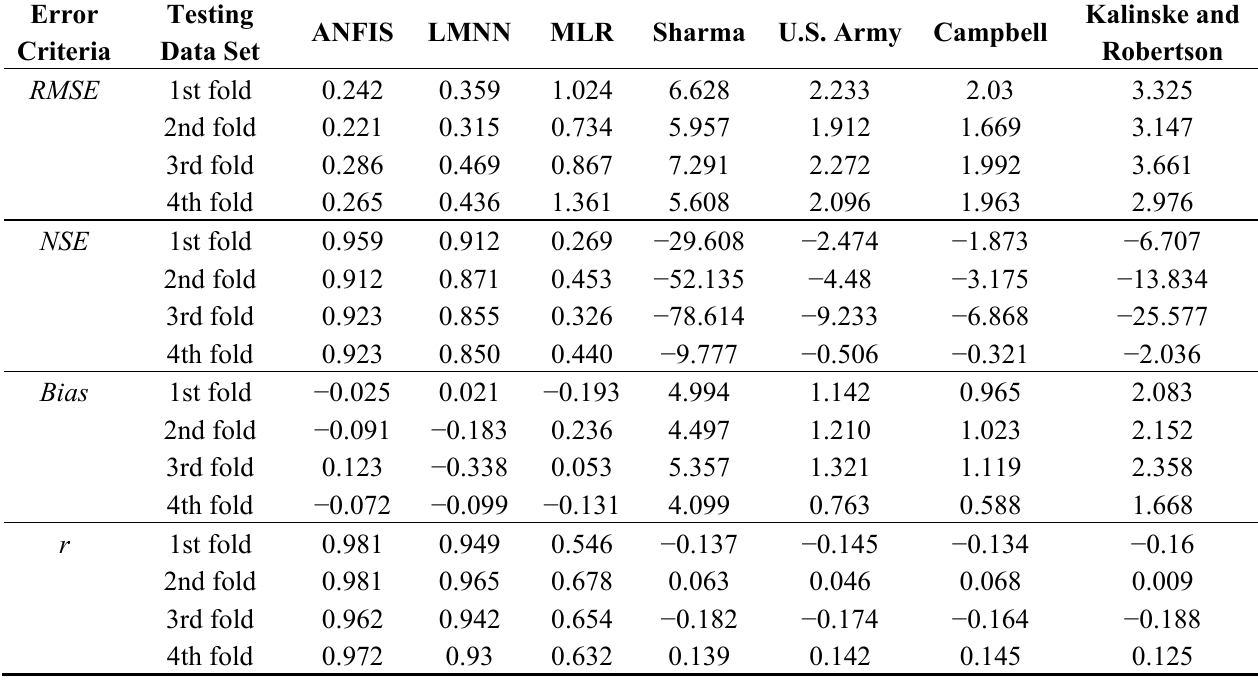
Table 3. Values of model performance indices and error functions for the